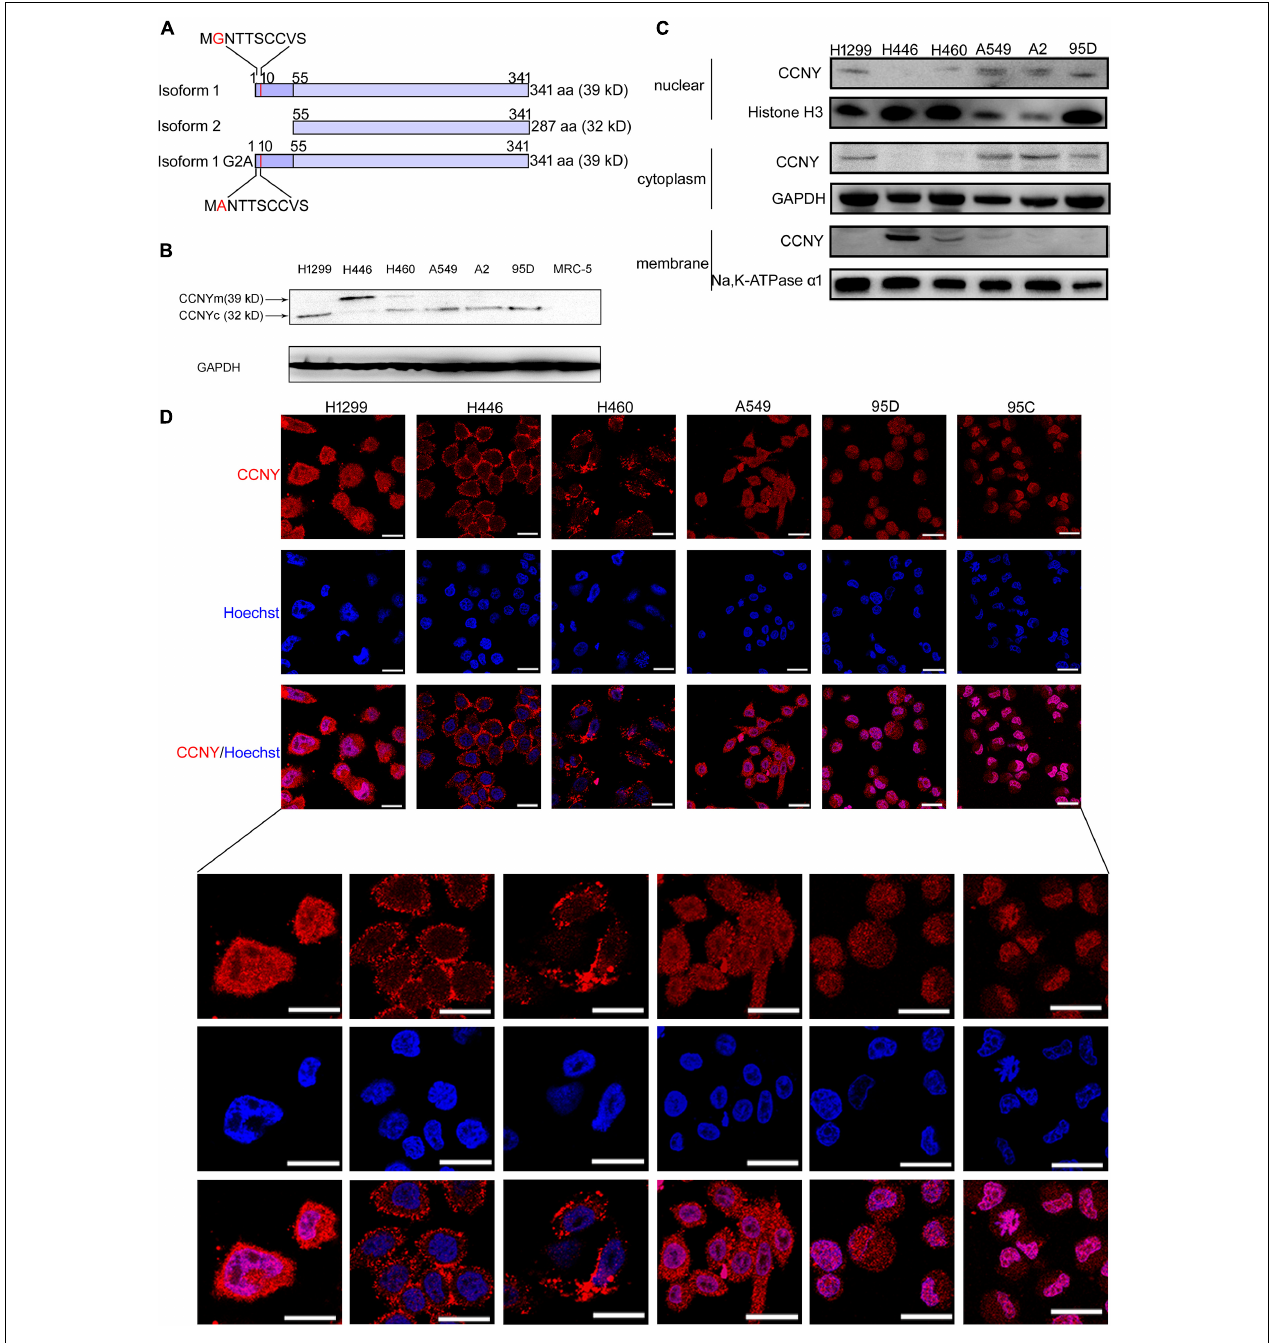
FIGURE 1 | CCNYm and CCNYc were highly expressed in lung cancer cells. (A) A simple view of the amino acid sequence for CCNY isoforms. The letter G with red color in the CCNY isoform one sequence is the myristoylation signal motif. (B) The levels of CCNY and loading control GDPAH in lung cancer cells and MRC cells were determined by WB. (C) Western blot was done using cell cytoplasmic extracts, membrane extracts and nuclear extracts, respectively. The CCNY level in cell membrane, cytoplasm and cell nucleus was shown in the figure. (D) Intracellular localization of CCNY in lung cancer. Bars represent 20 µ m. The red fluorescence represents CCNY protein, and the blue fluorescence is the nuclear DNA staining with Hoechst 33342.